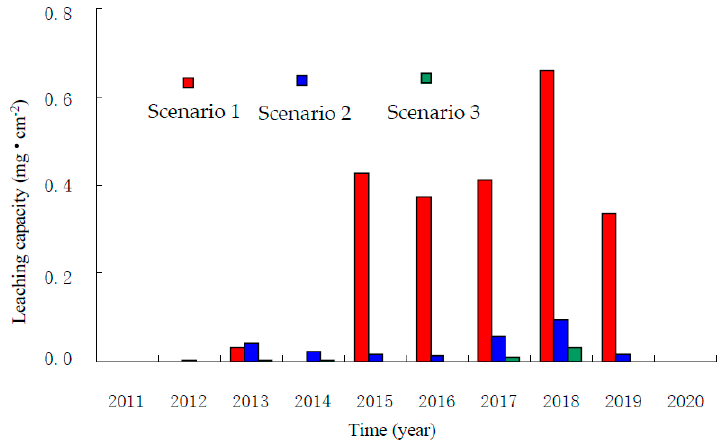
Figure 11. The amount of nitrate nitrogen leached into the vadose zone.